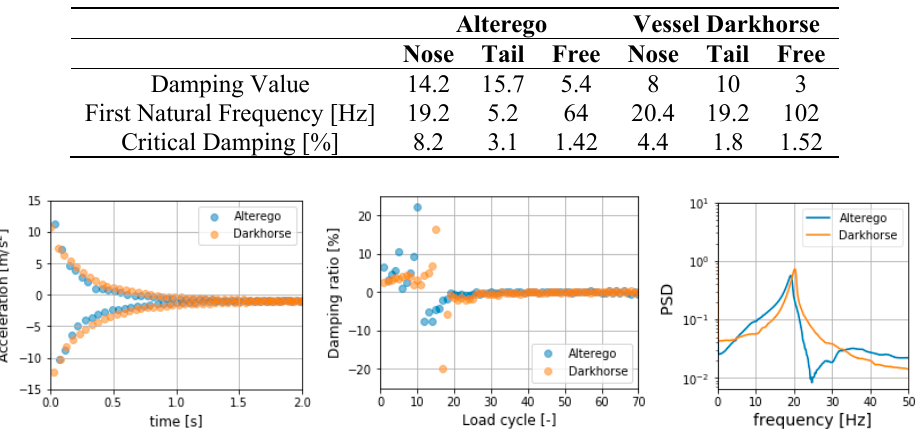
Figure 6. Comparative results from nose decay test. ( left ) comparison of decay tests; ( center ) Damping ratio in each cycle; ( right ) Power Spectral Density and natural frequencies.